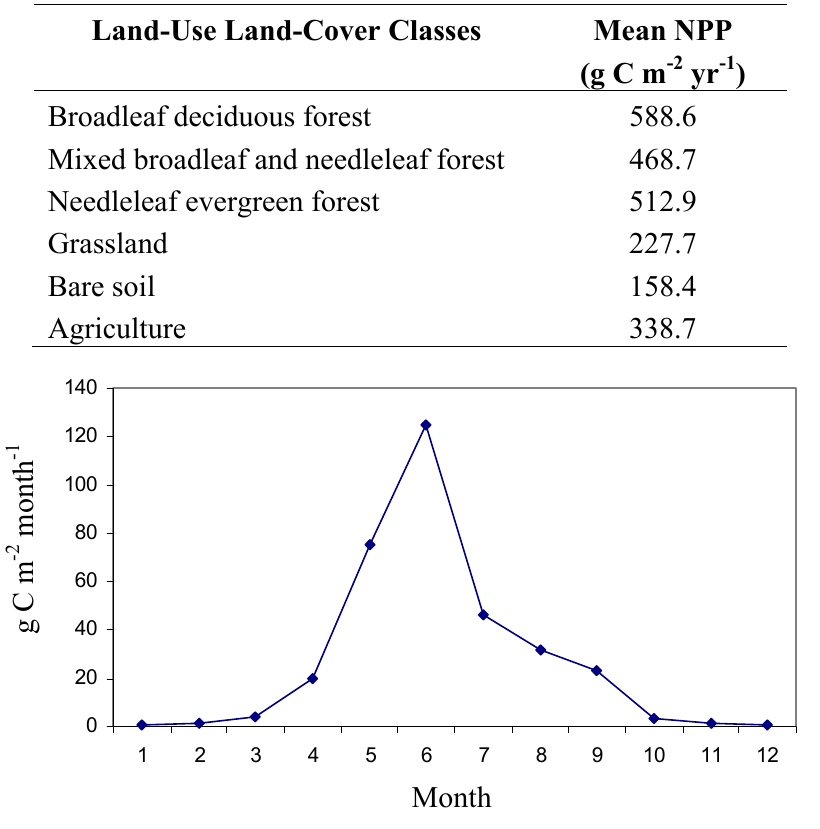
Figure 7 . Monthly NPP results from the CASA